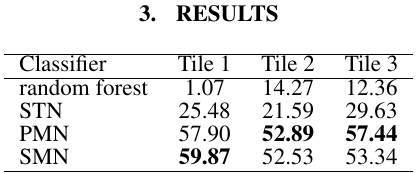
Table 2. Average land use class F1 scores of the classifiers on the three test